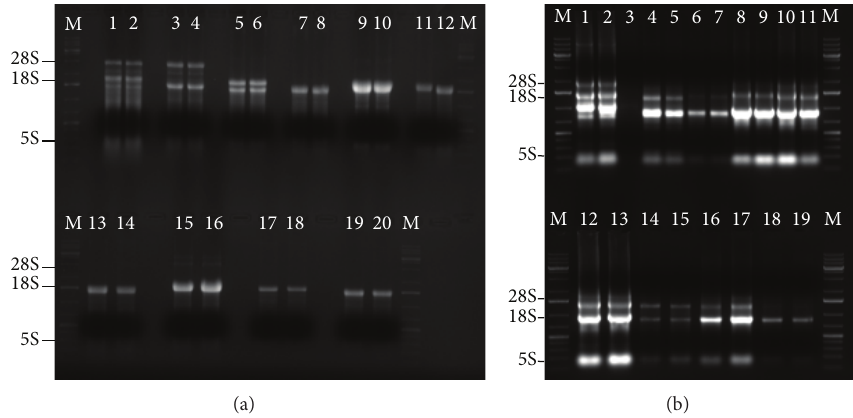
Figure 1: Gel images showing the banding profiles of the various insect RNA sampled. (a) Lane M: O’GeneRuler 1kb DNA Plus (Thermo Scientific), Lanes 1 and 2: aphids, Lanes 3 and 4: thrips, Lanes 5 and 6: whiteflies, Lanes 7 and 8: mosquitoes, Lanes 9 and 10: tsetse flies, Lanes 11 and 12: fruit flies, Lanes 13 and 14: stem borer, Lanes 15 and 16: silk worm, Lanes 17 and 18: wasps, and Lanes 19 and 20: bees shows appearance of RNA on 1.2% formaldehyde agarose (FA) gel. On the other hand, (b) shows RNA appearance on 1.2% agarose non-denaturing